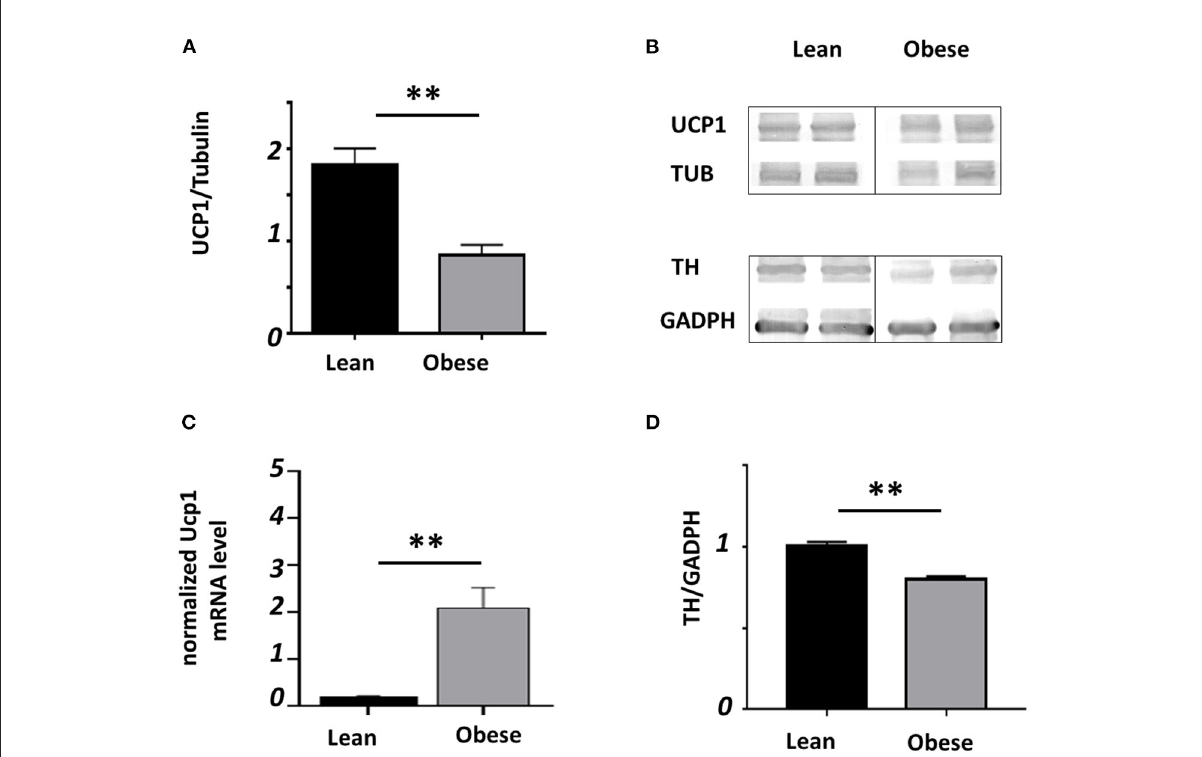
FIGURE4 Relative presence of UCP1 and TH in iBAT. Black bars represent lean and gray bars obese mice. (A) Relative presence to tubulin lean ( n = 14) and obese ( n = 8). (B) Representative blots. (C) Relative mRNA for Ucp1 ( n = 6 lean, n = 4 obese) analyzed by RT-qPCR and normalized to the reference gene tbp. (D) Relative abudance of TH ( n = 5 each group); ( ** P < 0.01).